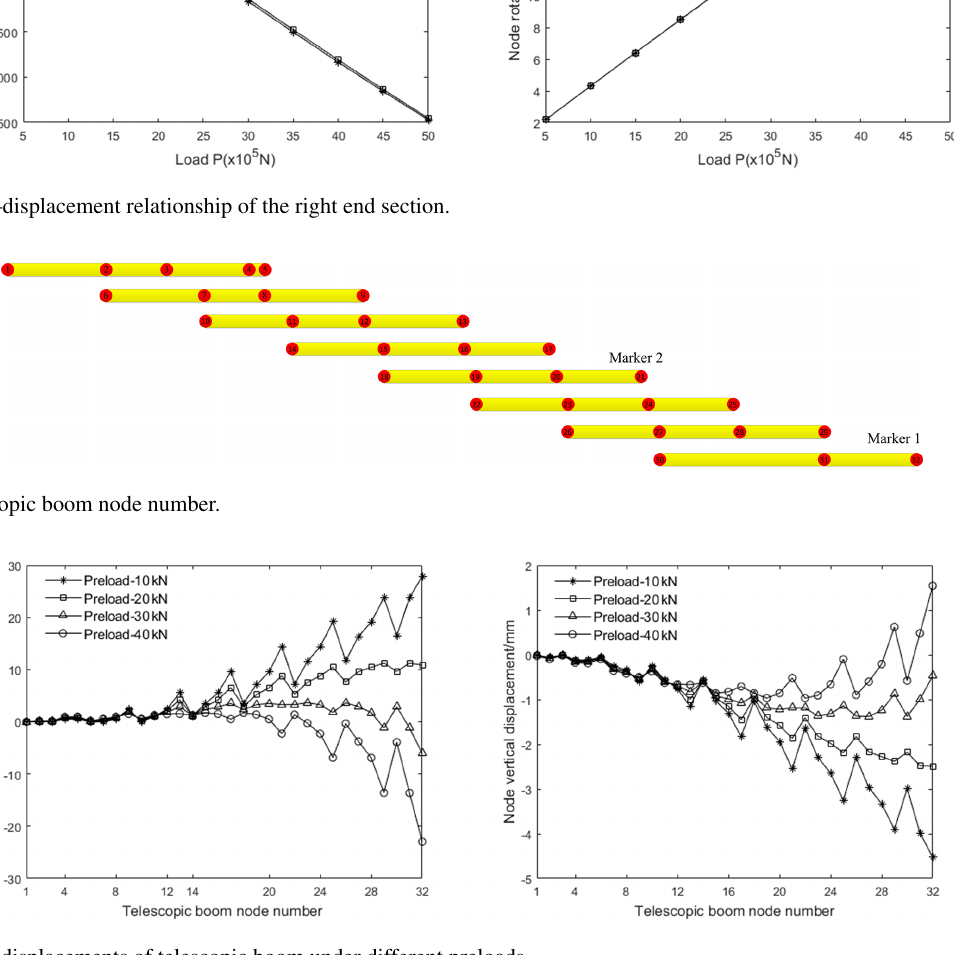
Figure 16. Nodal displacements of telescopic boom under different